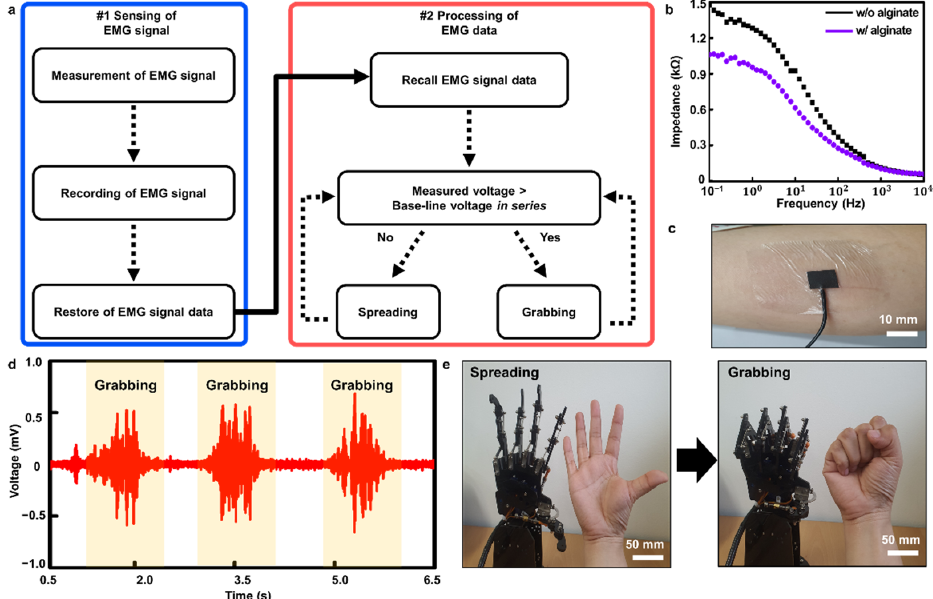
Figure 4. Demonstration of human − robot interface with stretchable and self-healable electrodes. ( a ) Flow diagram of EMG signal recording and processing. ( b ) Impedance data of the composite with and without alginate. ( c ) A photograph of the electrode attached on the skin. ( d ) Recorded EMG signals using the electrode. ( e ) Demonstration of the human − robot interface (spreading and grabbing).